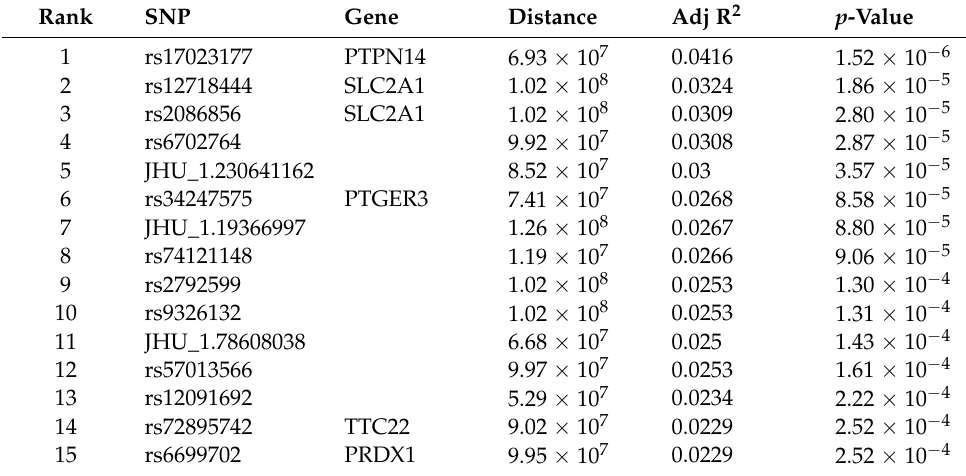
Table 5. Top 30 long-range cis-meQTLs nominally associated with